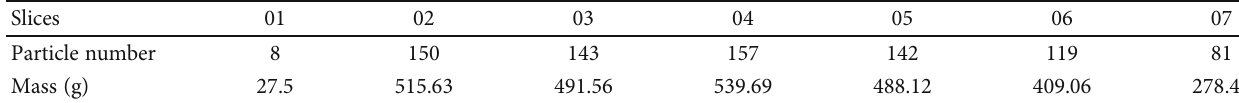
Table 6: Mass of bird impact fan blade